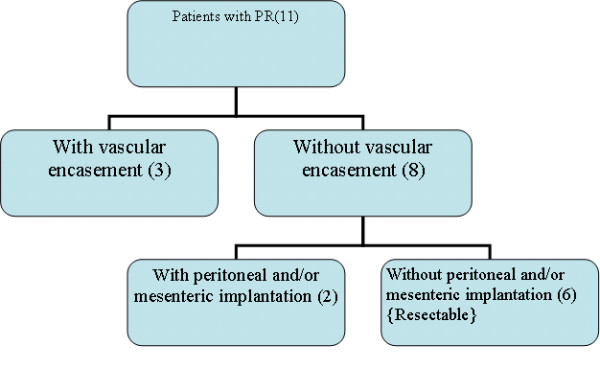
Treatment profile of patients with partial response.